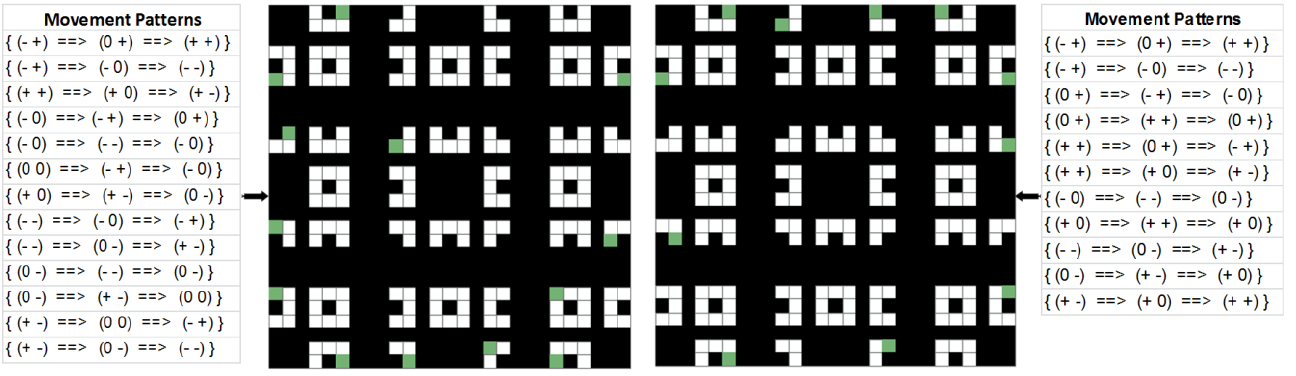
Figure 5. Two trajectory pairs during two different time intervals.